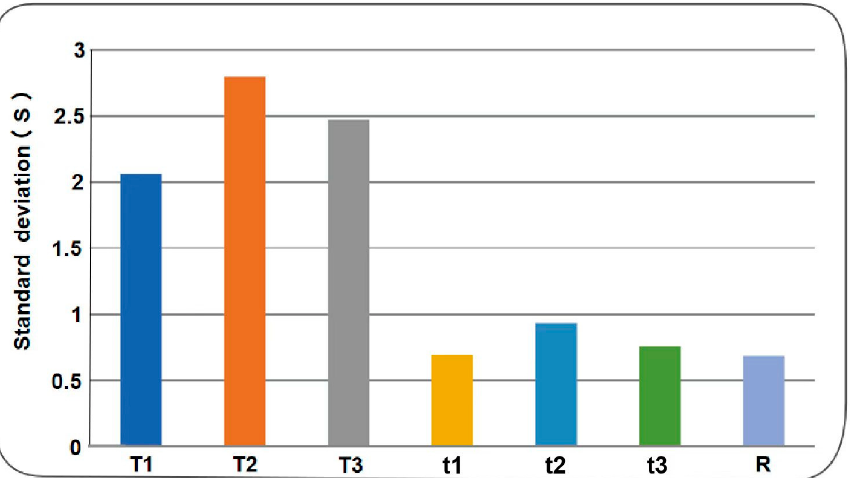
Figure 6. The standard deviation of the data analysis. (from left to right, T1, T2, T3, t1, t2, t3,